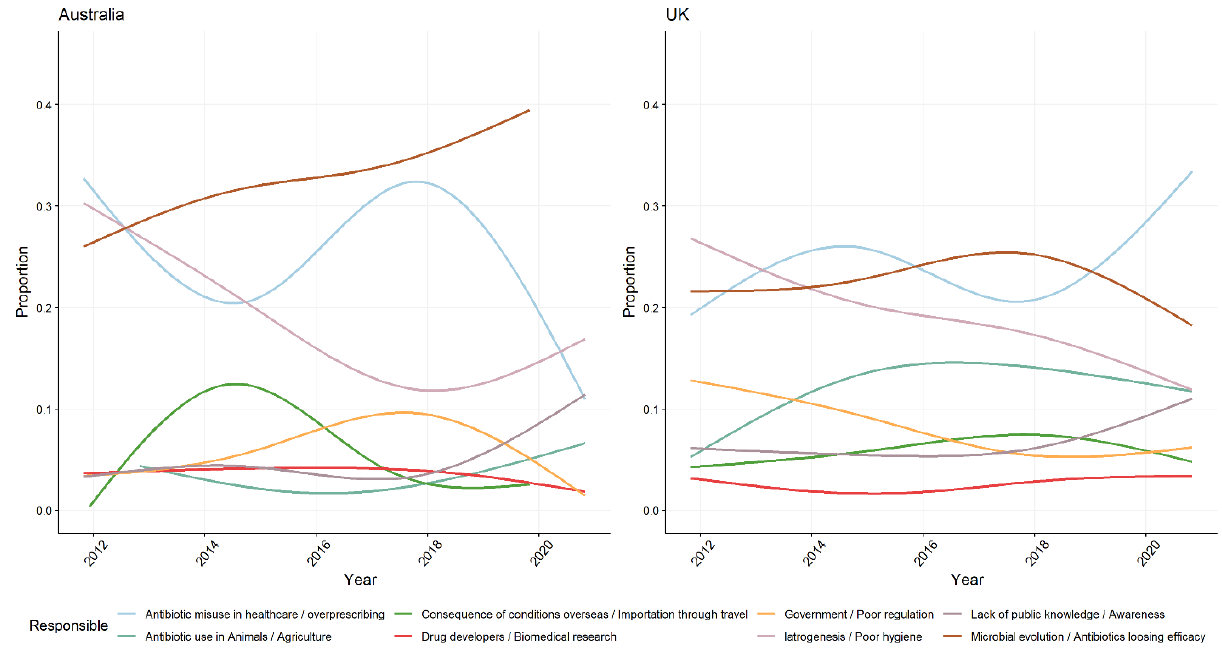
Figure 6. Proportion of different framings in Australian and UK newspapers of who and what is responsible for causing AMR.